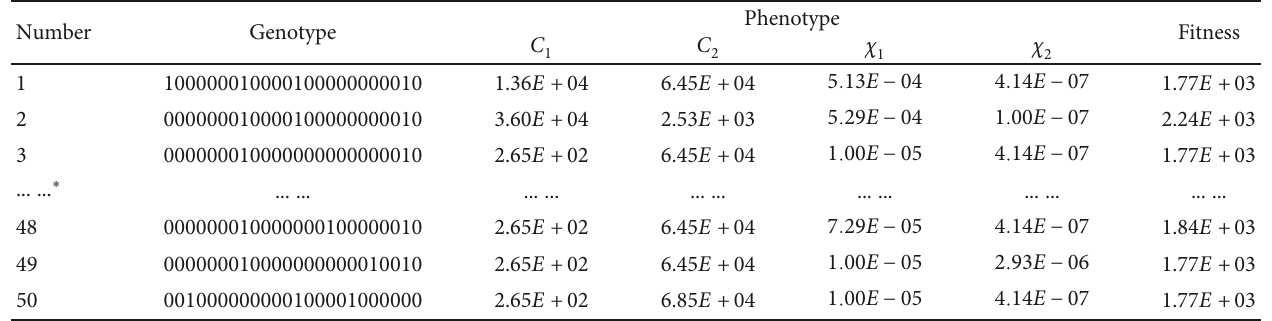
Table 3: The 2nd generation population.